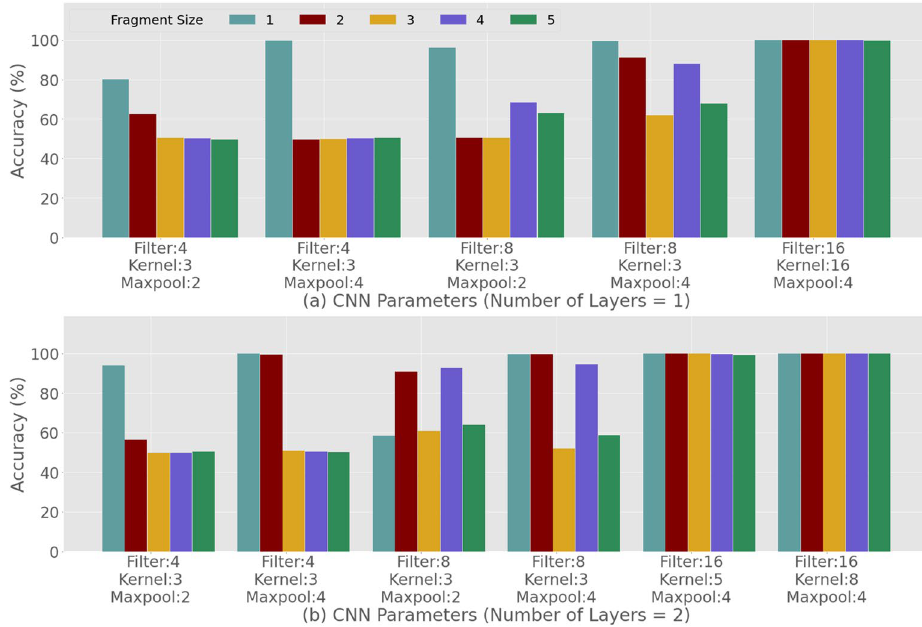
Figure 7. DNN-based detection of trigger samples amongst genuine E. coli plasmids: hyper-parameter optimization (no encryption or retention) using ( a ) 1 and ( b ) 2 hidden layers.